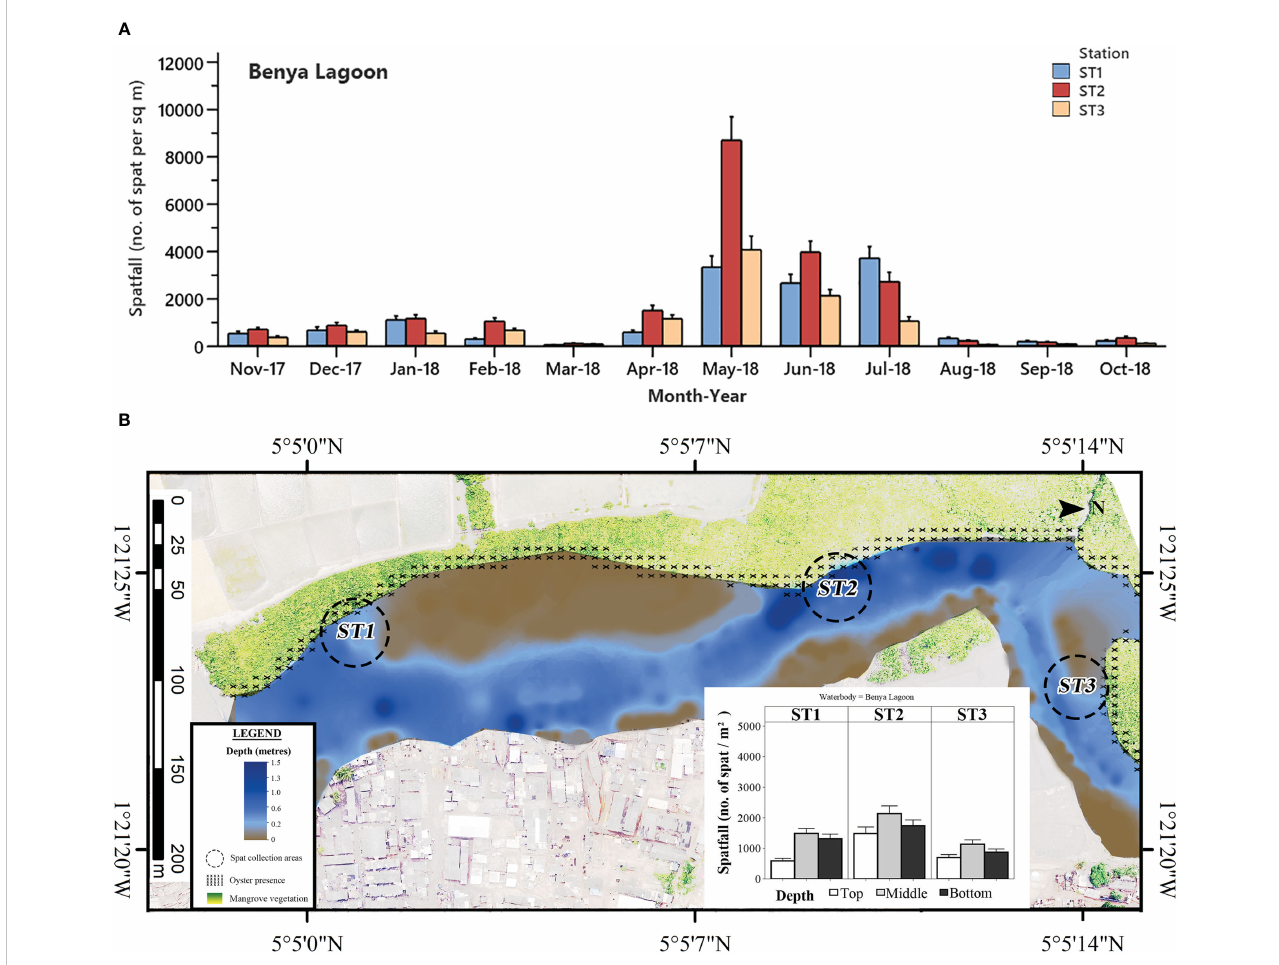
FIGURE 5 (A) Mean monthly C . tulipa spatfall (spat m -2 ) at stations (ST) in the Benya Lagoon pooled from collectors at all depths for each water body. Interval bars are standard errors (S.E.) of the mean. (B) Geomorphological representation of the Benya Lagoon at low tide showing depth pro fi le, oyster presence and charted C . tulipa spat availability in the water column at the experimental spat collection stations. Map generated from orthomosaic image of UAV fl ights for this study in June